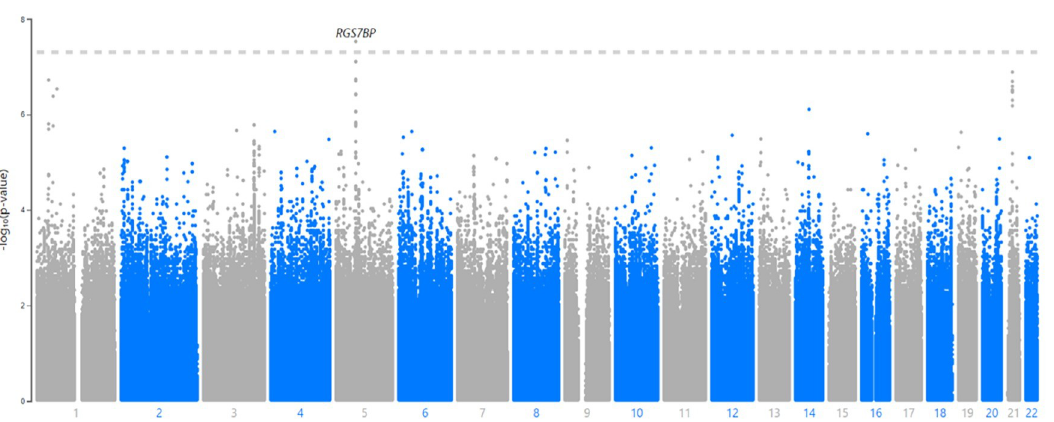
Fig 2. Manhattan plot for meta-analytic p-values of association between SNPs and TBscore. The Manhattan plot shows the inverse log(10) of the p-values for the association between each SNP and TBscore on the y-axis and the x-axis represent the physical location of each SNP on the chromosomes, which are in order from